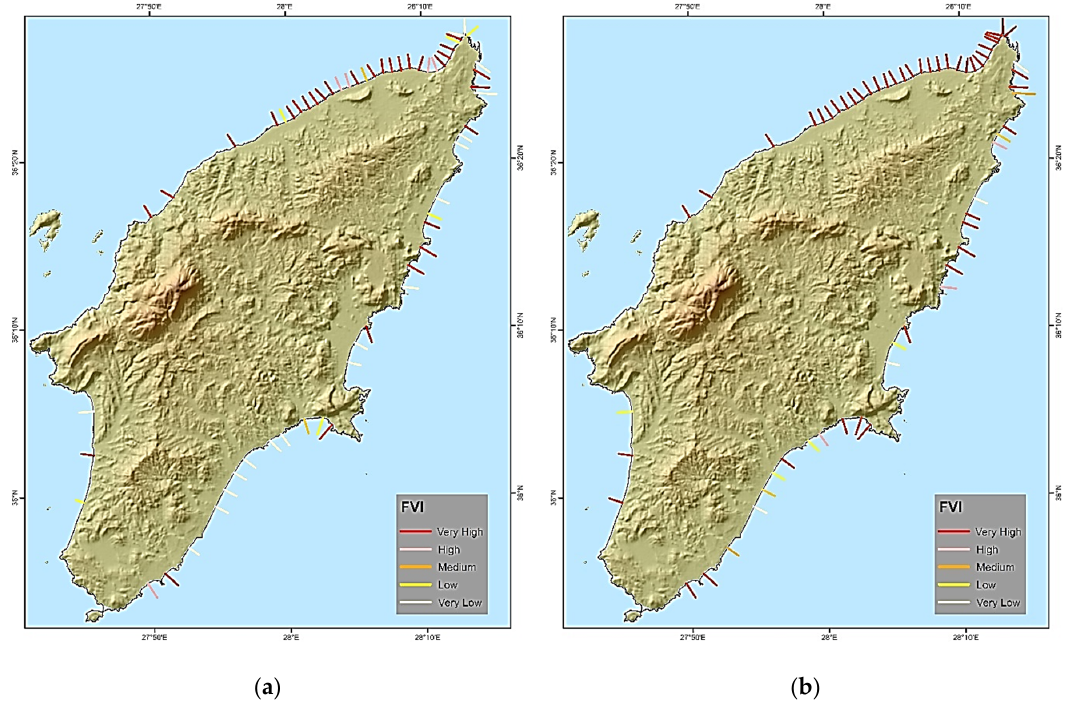
Figure 9. Spatial variation of the Flood Vulnerability Index in Rhodes Island for ( a ) weak (class I) and ( b ) extreme (class V) wave storms.